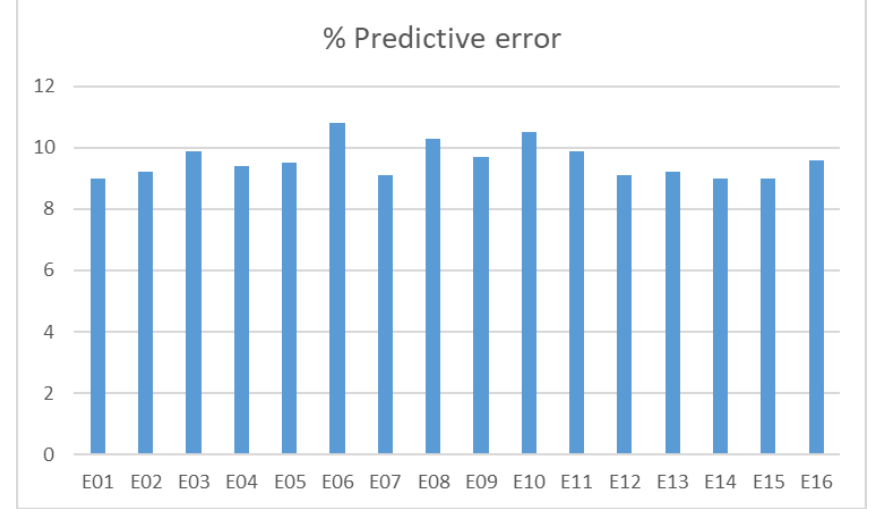
Figure 10. Predictive Error Graph for Al.